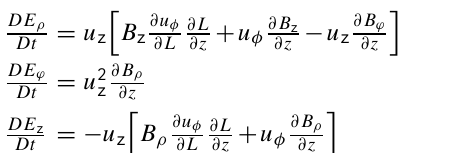
Figure 2: Calculated magnetic field profiles (top) and convection electric fields (bottom) as a 405 Fig. 2. Calculated magnetic field profiles (top) and convection elec- function of axial distance from the centre of the current sheet, positive above the current 406 tric fields (bottom) as a function of axial distance from the centre of sheet and negative below. In both panels red indicates the radial component, blue the axial, 407 the current sheet, positive above the current sheet and negative be- and green the azimuthal. The electric field is calculated for two cases i) where the current 408 low. In both panels red indicates the radial component, blue the ax- sheet is in rapid axial motion (u z ≠ 0) (solid lines) and ii) where the current sheet is at rest with 409 ial, and green the azimuthal. The electric field is calculated for two respect to Titan (u z =0) (dashed lines). The dotted vertical lines indicate the extents of the 410 cases (i) where the current sheet is in rapid axial motion ( u z 6= 0) current sheet as defined by the B ρ <=0.6B criterion of Simon et al. (2010a). 411 (solid lines) and (ii) where the current sheet is at rest with respect to Titan ( u z = 0) (dashed lines). The dotted vertical lines indicate the extents of the current sheet as defined by the B ρ < = 0 . 6 B criterion of Simon et al.